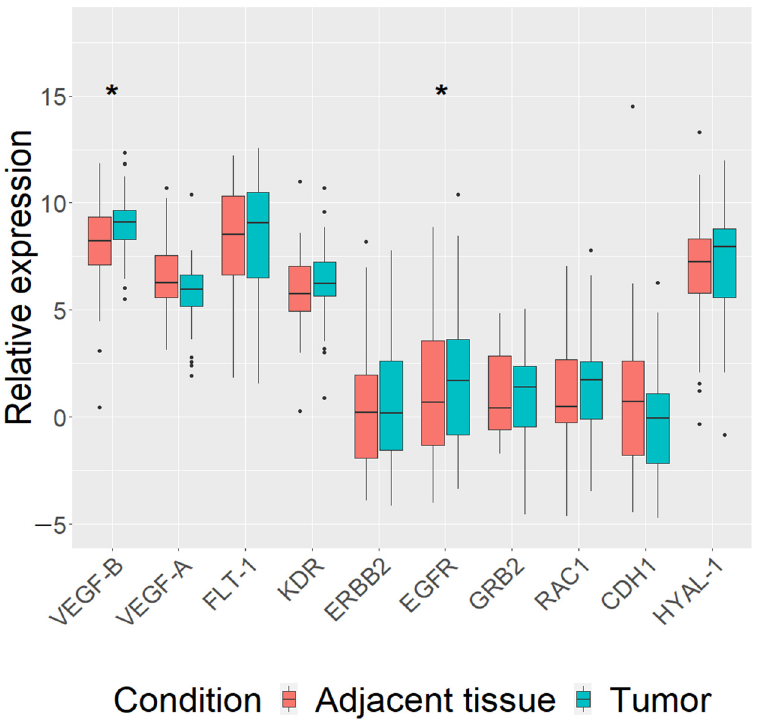
Figure 1. Expression levels of 10 analyzed genes ( VEGF-B , VEGF-A , FLT-1 , KDR , ERBB2 , EGFR , GRB2 , RAC1 , CDH1 and HYAL-1 ) in canine mammary tumors (CMTs) and tumor adjacent tissues in all studied dogs. qRT-PCR data are represented as delta Ct values. Dots indicate outliers. * p < 0.05 measured with Wilcoxon or t -tests.